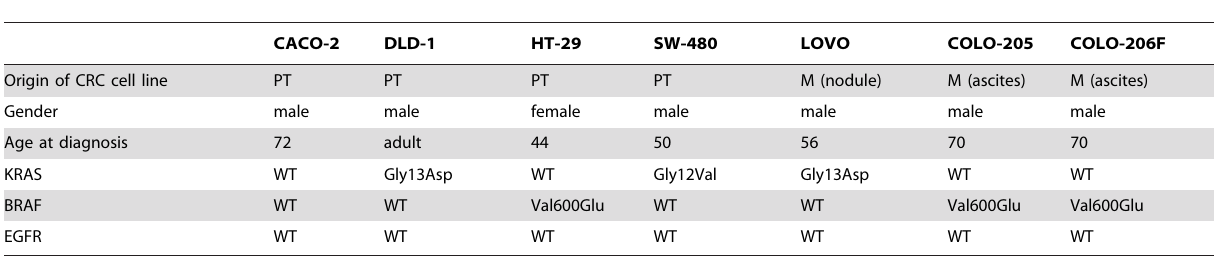
Table 1. Clinical and molecular characterization of the CRC cell